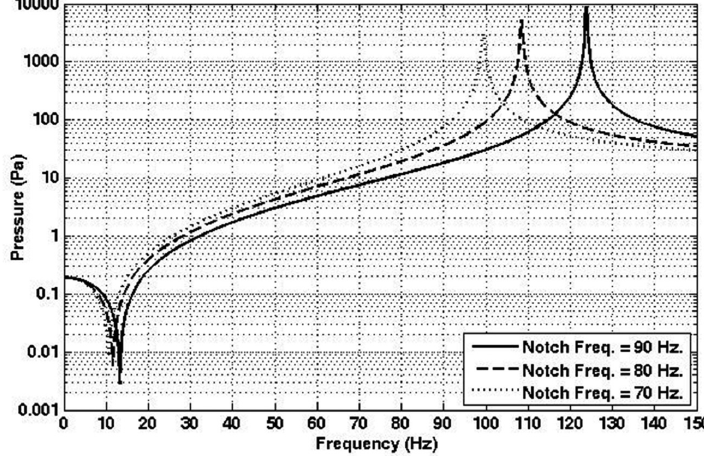
Fig. 8. Upper chamber pressure in the hydraulic engine